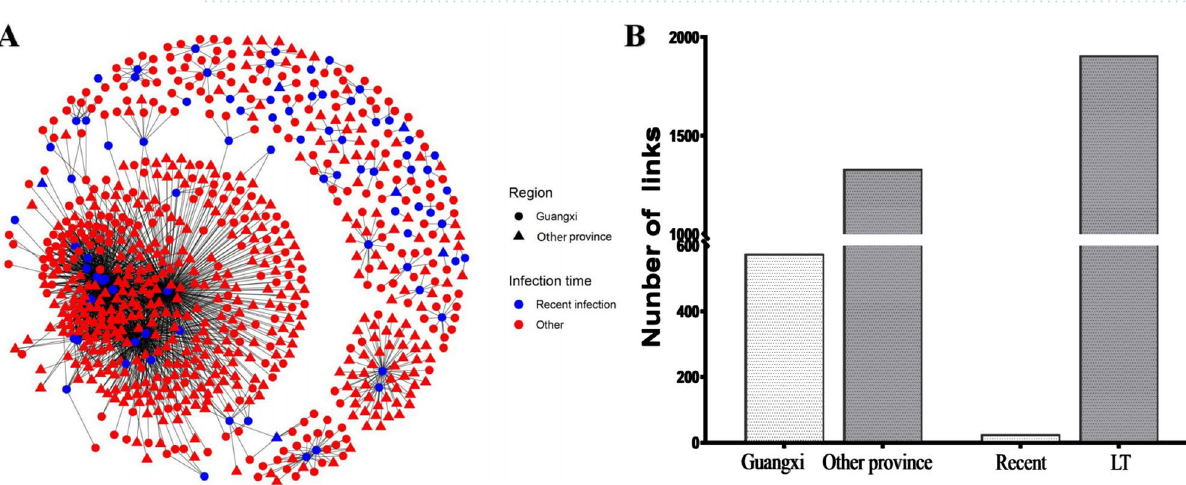
Figure 4. Risk factors of recently infected individuals. The network was constructed using a custom R script with the network package in R version 4.0.2 software. ( A ) Recently infected individuals in transmission networks. Different shapes represent different provinces: solid circle: Guangxi; solid triangle: other provinces. Different colours represent different infection time. Blue, recent infection; red, long-term infection. ( B ) The total number of the links of recent infections in Guangxi with other infections from different areas or for different infection times. Recent recent infection, LT long-term